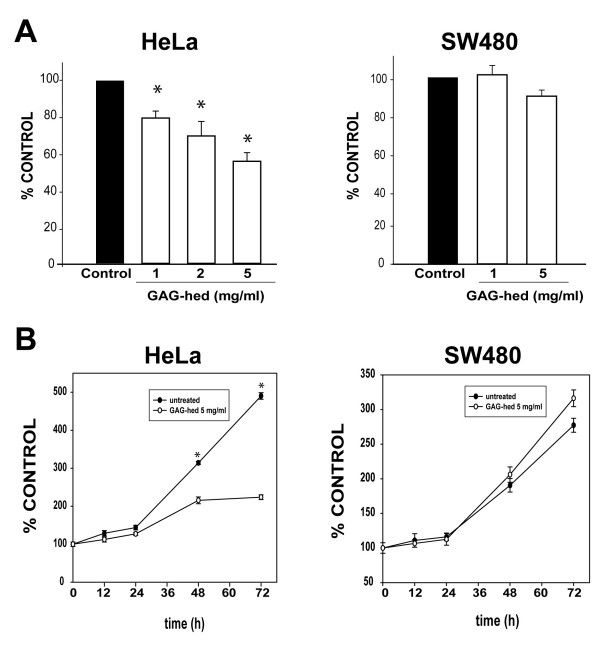
Cell viability and proliferation rates were affected by GAG-hed. HeLa and SW480 cell viability was assessed by the MTT method. Cells were seeded on a 24-well plate. In (A), cells were treated with increasing doses of GAG-hed for 48 h. In (B), after GAG-hed treatment (5 mg/ml) cells were incubated and analyzed at 12 h intervals for 3 days. *, differences were significant when compared with equivalent untreated cells (control) in all cases (Student's t-test p < 0.001; n = 4).